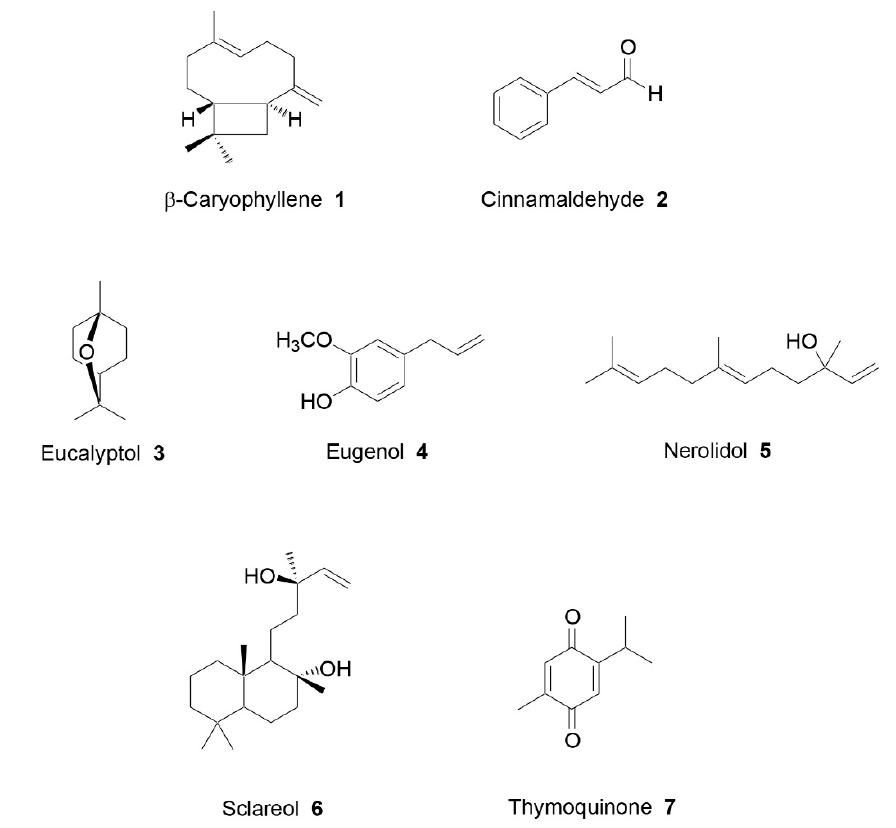
Figure 2. EO chemical components with antiarthritic potential [55–64].